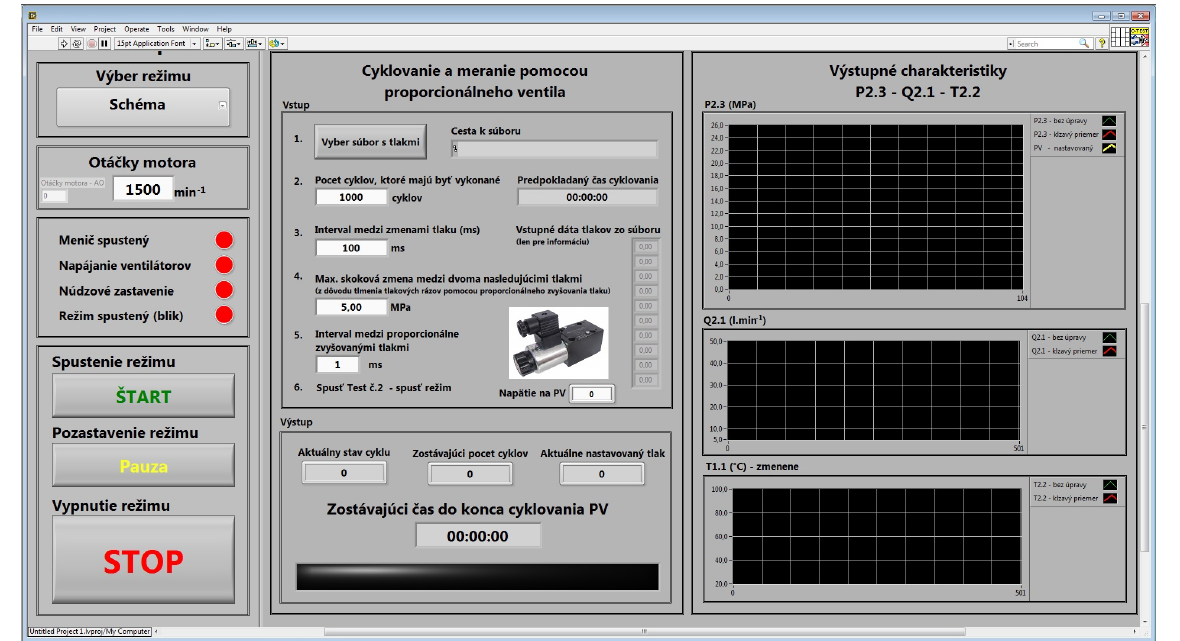
Figure 7. Control system of proposed laboratory equipment in LabVIEW.